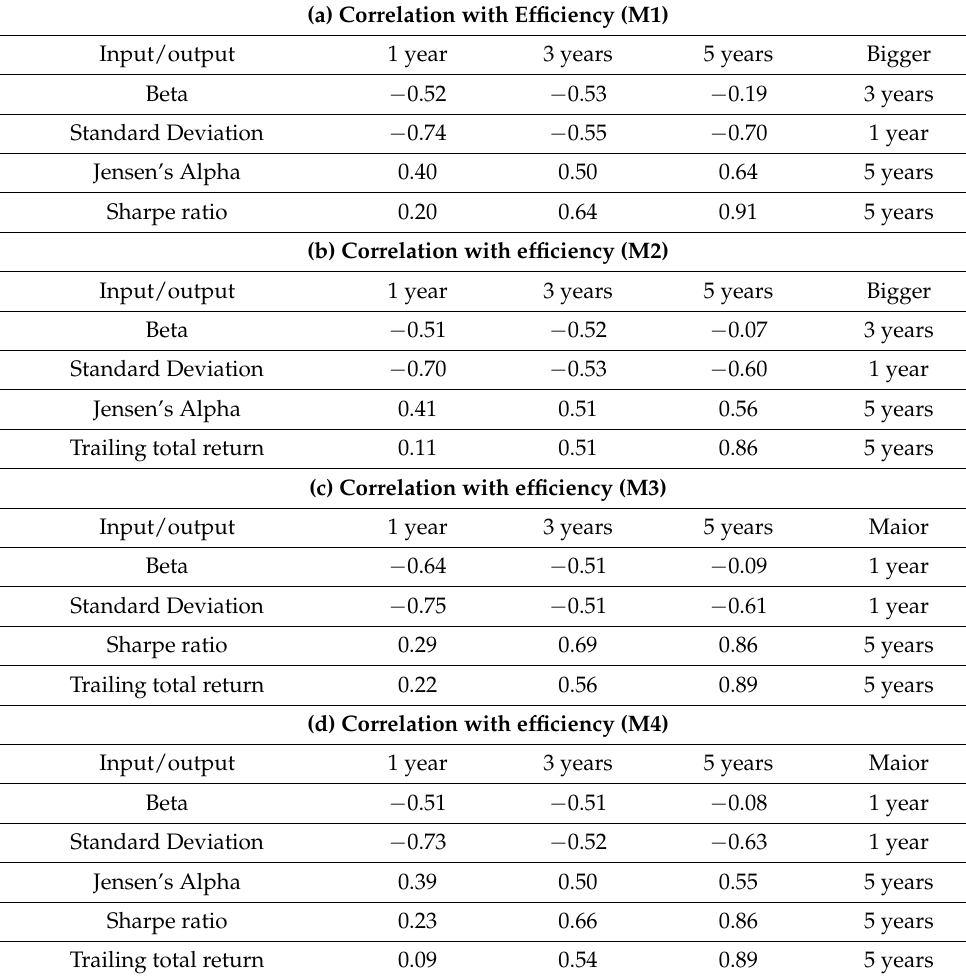
Table A6. Correlation of the efficiency scores with inputs and outputs for each model. (a) Correlation with Efficiency (M1)